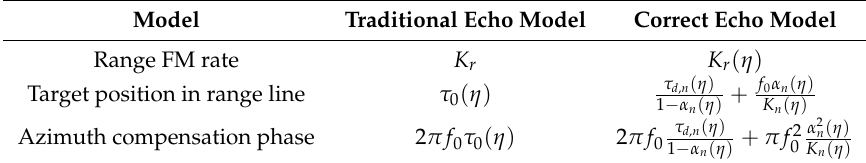
Table 1. The comparison between the traditional echo model and the correct echo model Model Traditional Echo Model Correct Echo